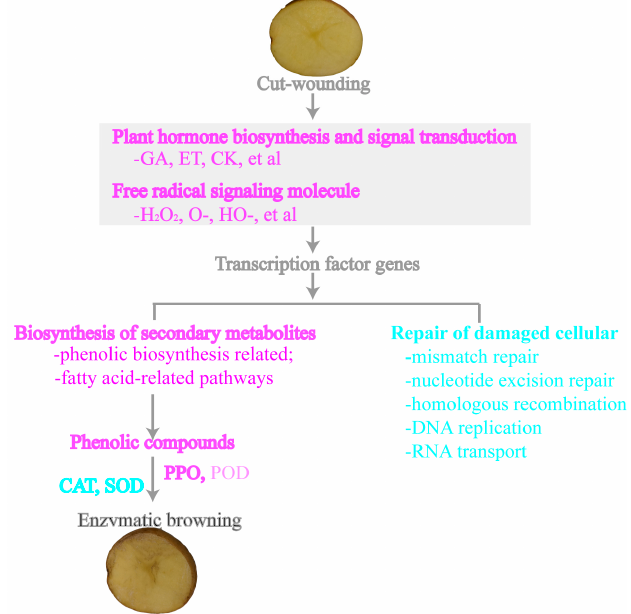
Figure 8. Hypothetical model of potato tubers in response to cut-wounding. Purple and cyan refer to the genes up-regulated and down-regulated in response to cut-wounding.